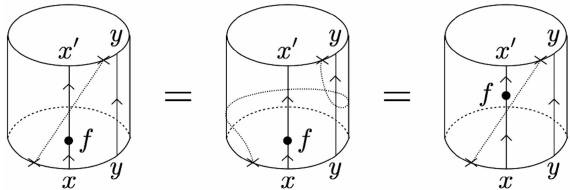
is the inverse of yx